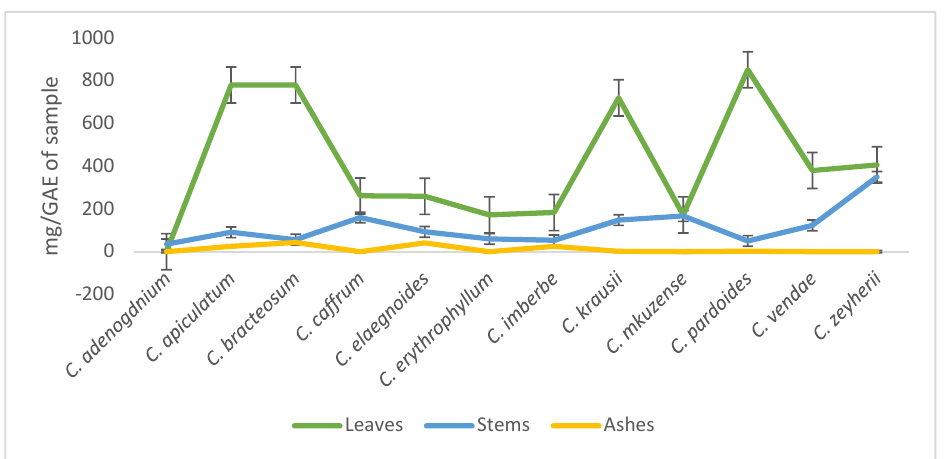
Figure 1. Evaluation of the phenolic compounds in the leaves, stems, and ashes of twelve Combretum species.